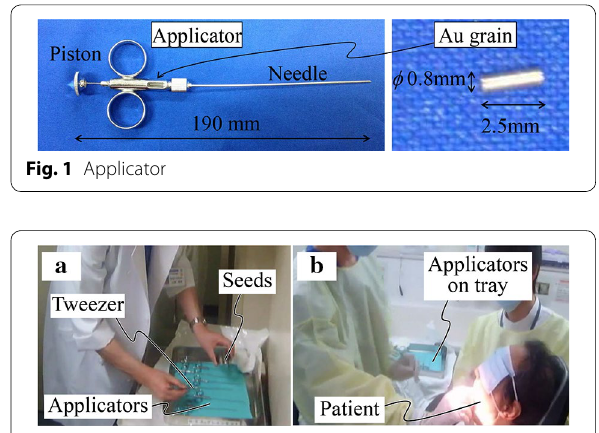
Fig. 2 Scenes from traditional brachytherapy. a Applicators arranged on a tray. b Scene of the implantation